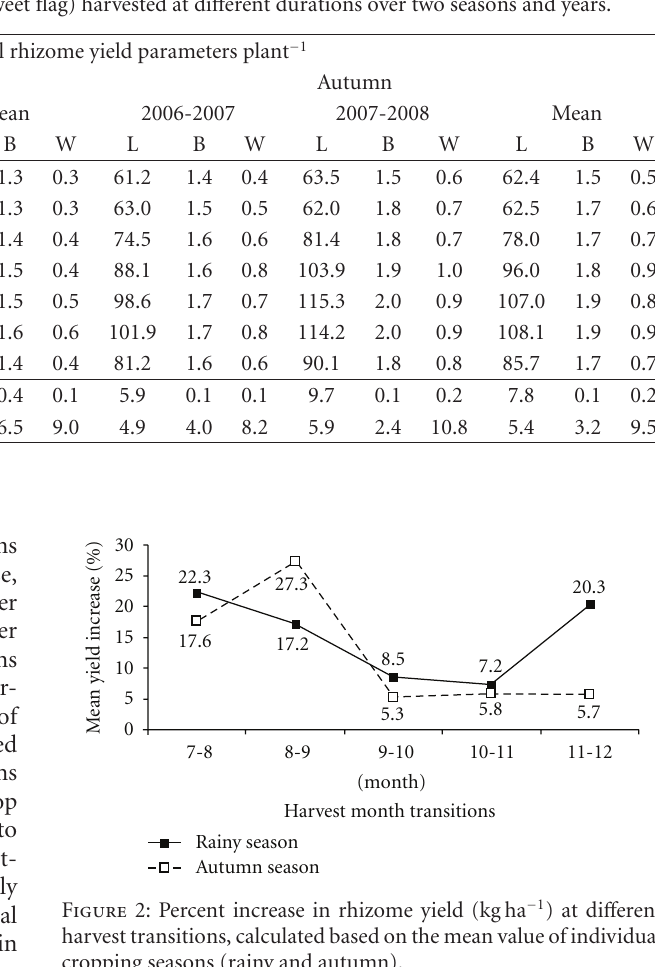
Table 3: Yield-dependant parameters of Acorus calamus (sweet flag) harvested at di ff erent durations over two seasons and years.